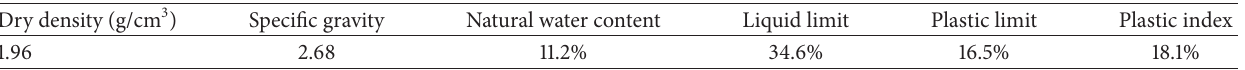
Table 1: Physical properties of the slip zone